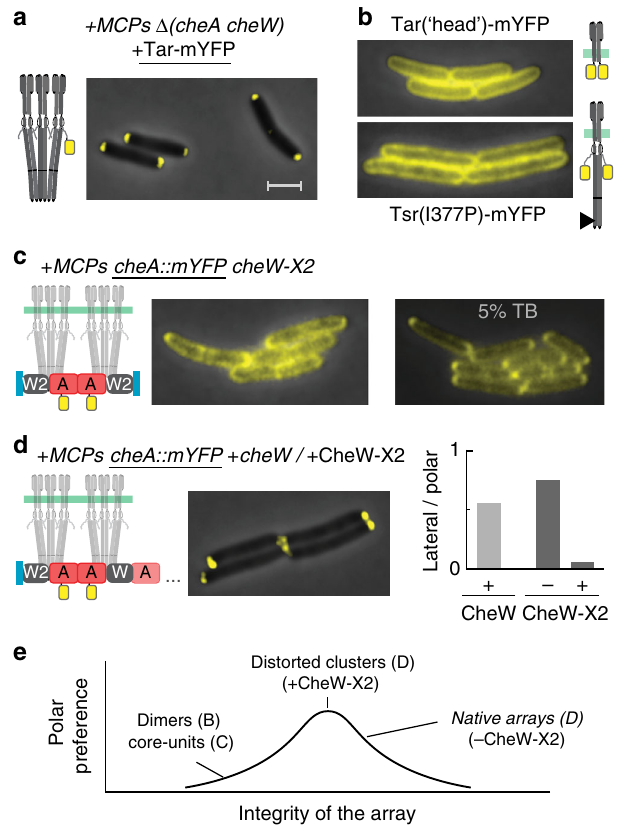
Fig. 4 Positioning of modi fi ed receptor clusters. a Tar-mYFP expressed in addition to the native receptors in cells lacking CheA and CheW